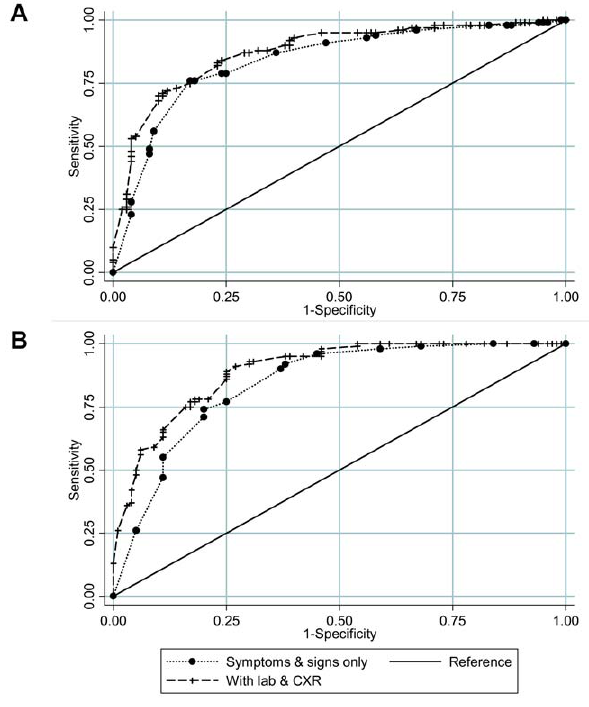
Figure 2. Receiver operating characteristic curves. (A) H1N1 versus acute respiratory illness, where Area under the receiver operating characteristic curve (AUROC) values are 0.839 for multivariate logistic regression model using symptoms and signs only, and0.874 when adding laboratory and chest radiograph (CXR) findings. (B) seasonal influenza versusacute respiratory illness. AUROCvalues are 0.842 for symptoms and signs only, and 0.893 when adding laboratory and CXR findings. doi:10.1371/journal.pone.0008453.g002 PLoS ONE |